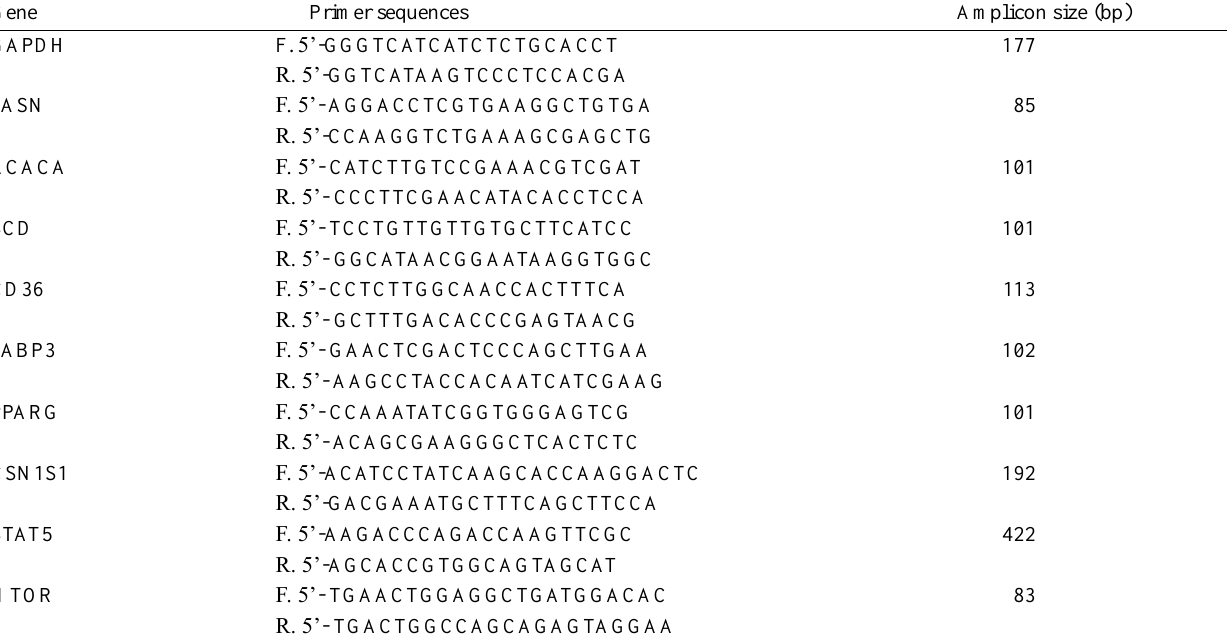
Table 1. Summary of genes, primer sequences and amplicon size